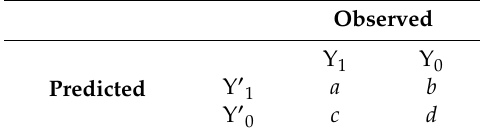
Table 2. The confusion matrix for receiver operating characteristic (ROC) curve